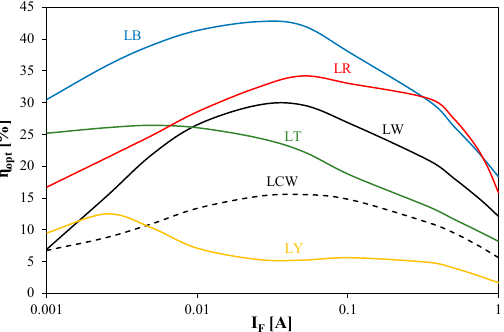
Figure 13. Measured dependences of optical efficiency of the tested power LEDs on forward current.